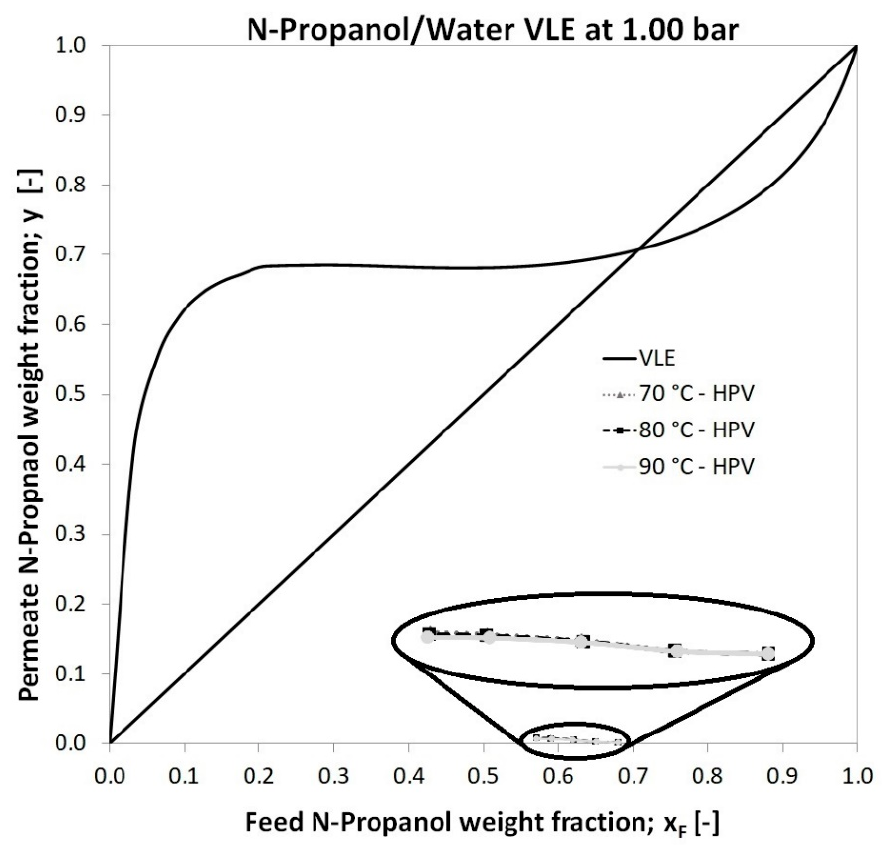
Figure 5. Experimental permeate n-propanol weight fractions (also enlarged version) of hydrophilic pervaporation on the n-propanol–water VLE diagram.